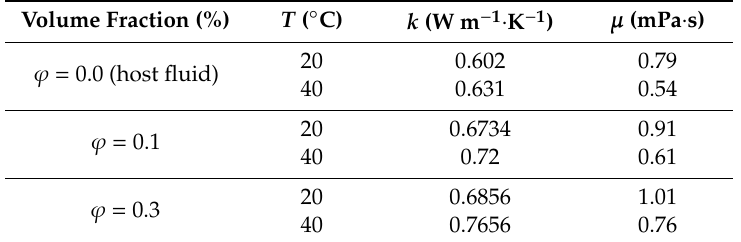
Table 3. E ff ective viscosity and thermal conductivity of MWCNT-Fe 3 O 4 / water